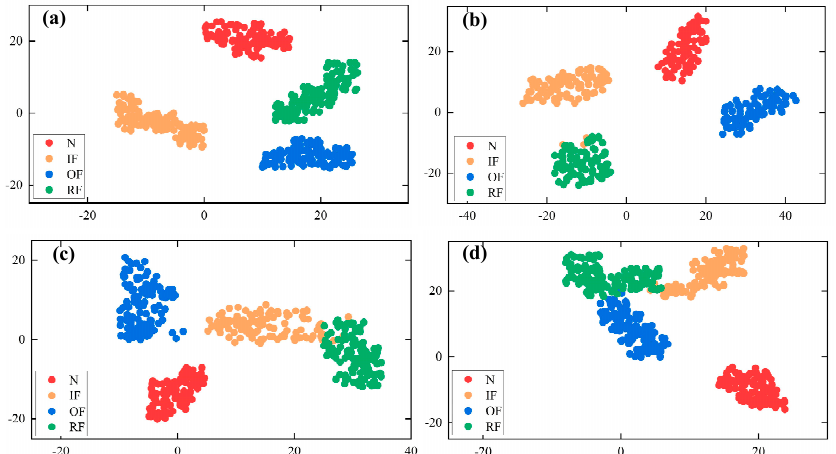
Figure 13. Feature classification visualization using t − SNE. (a) CBAM − DRN, (b) DRN, (c) CBAM − CNN, (d) CNN.